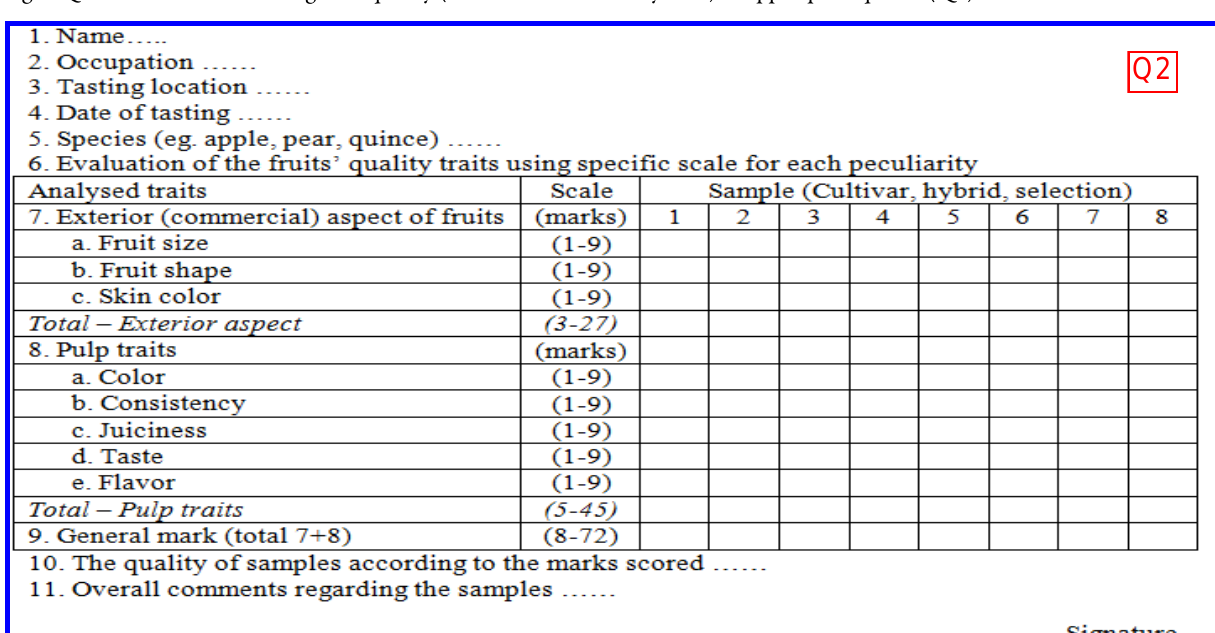
Fig. 2. Questionnaire for assessing fruit quality (cultivars, selections, hybrids) of apple, pear, quince